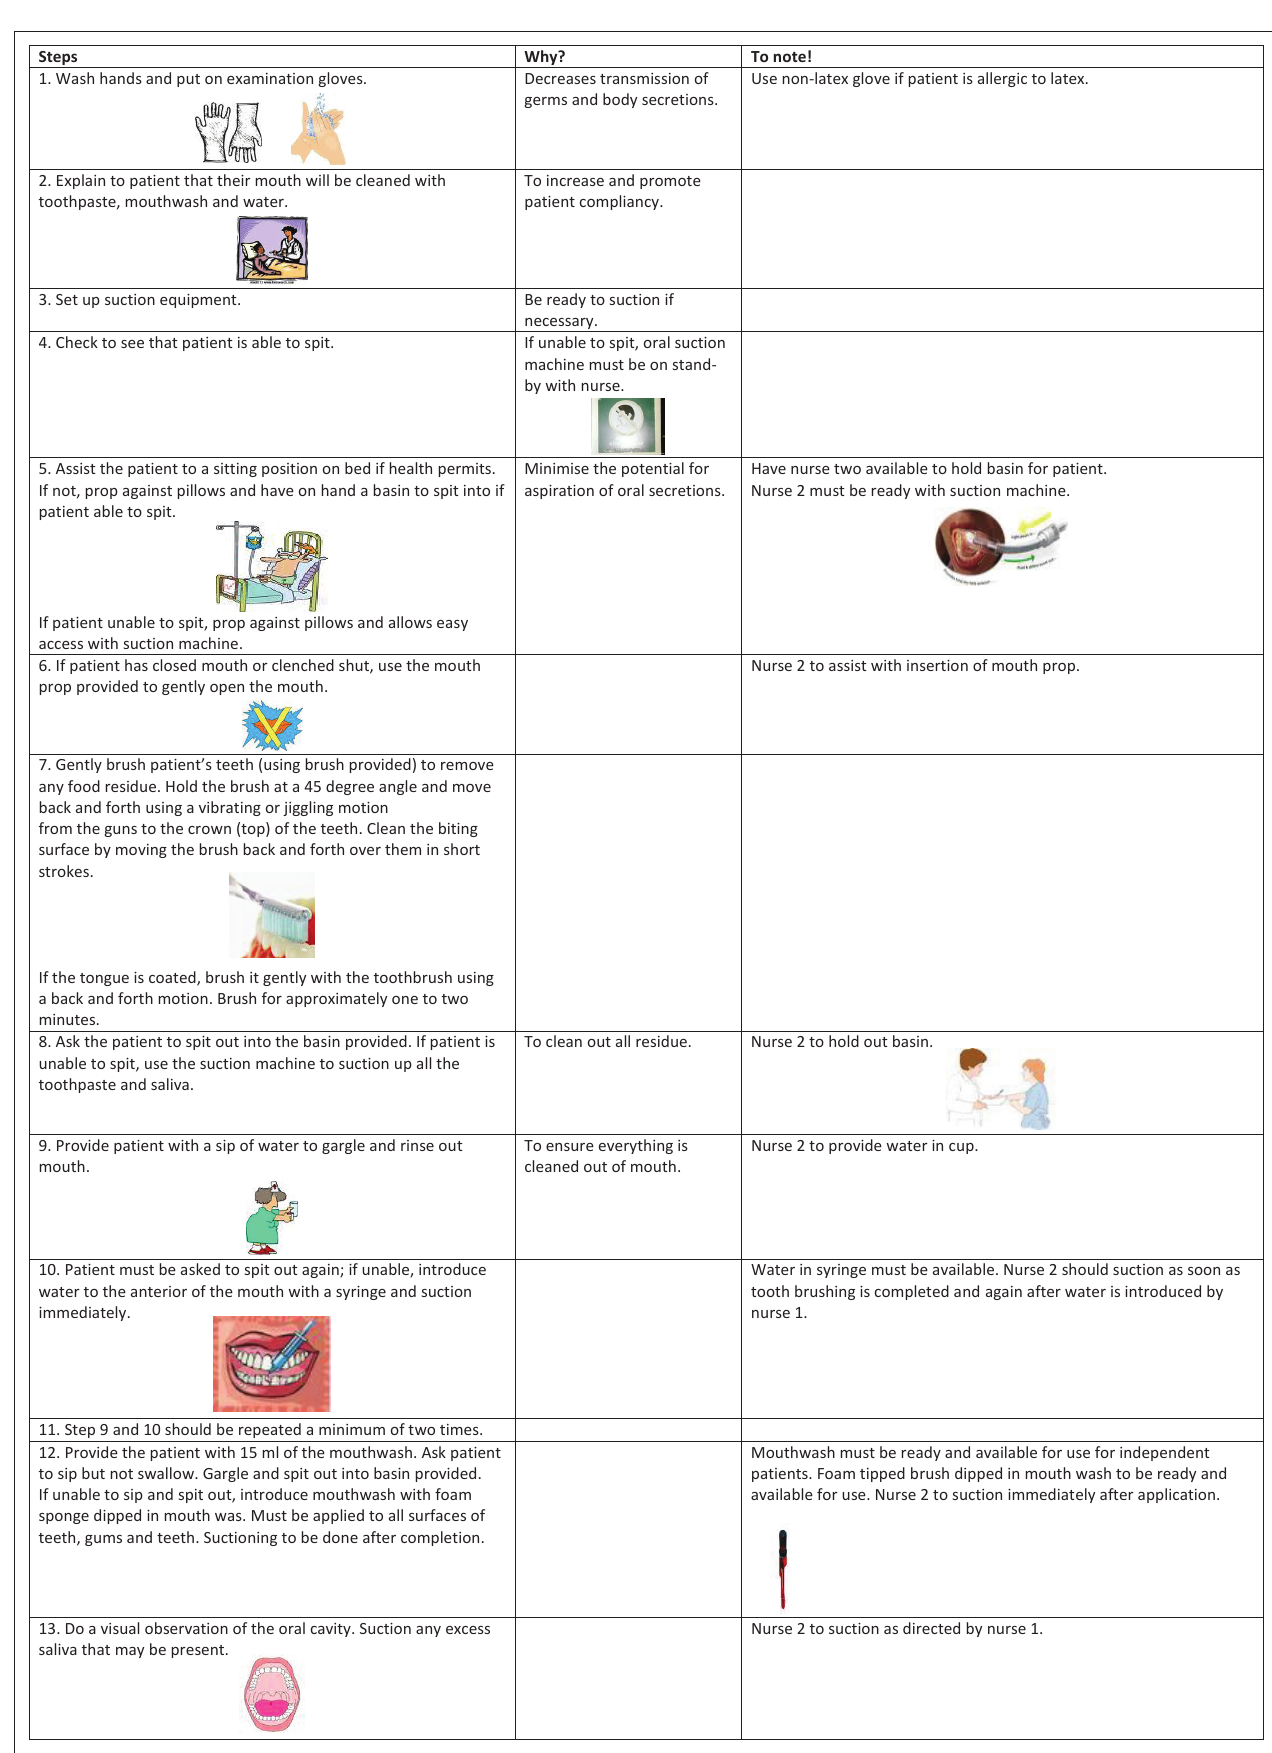
FIGURE 2: Procedure for oral